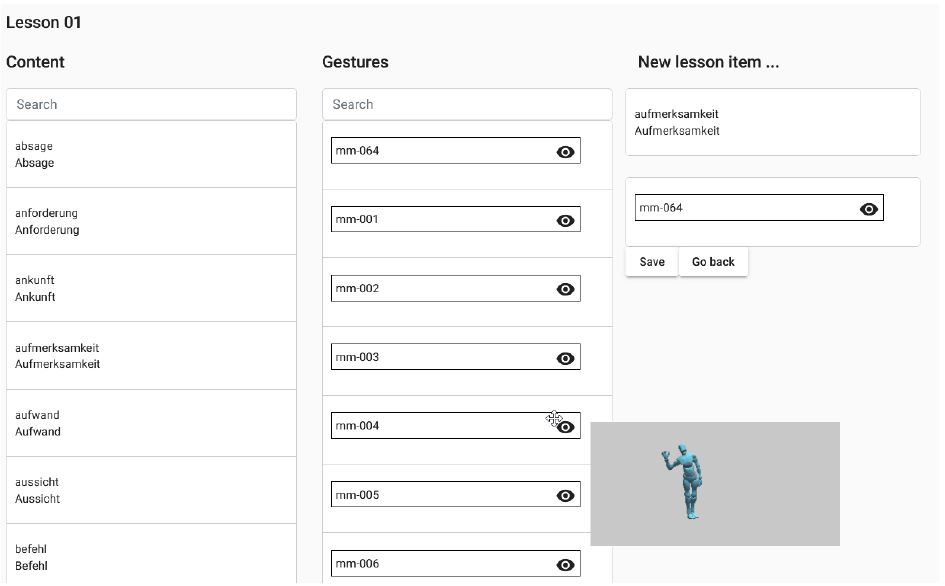
Figure 4. Screenshot of the reference implementation’s lesson configurator. GECs could be created by drag-and-drop of the content and gesture cards. Hovering over a gesture card previewed the gesture.